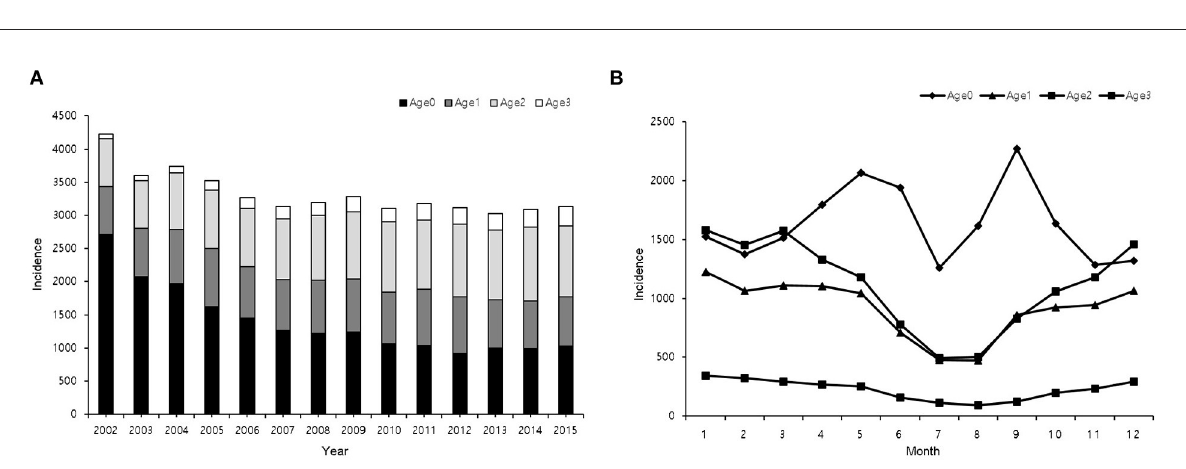
FIGURE2 Age distribution of patients with epistaxis who visited the hospital from 2002 to 2015. (A) Annual distribution of patients according to age. (B) Monthly distribution of patients according to